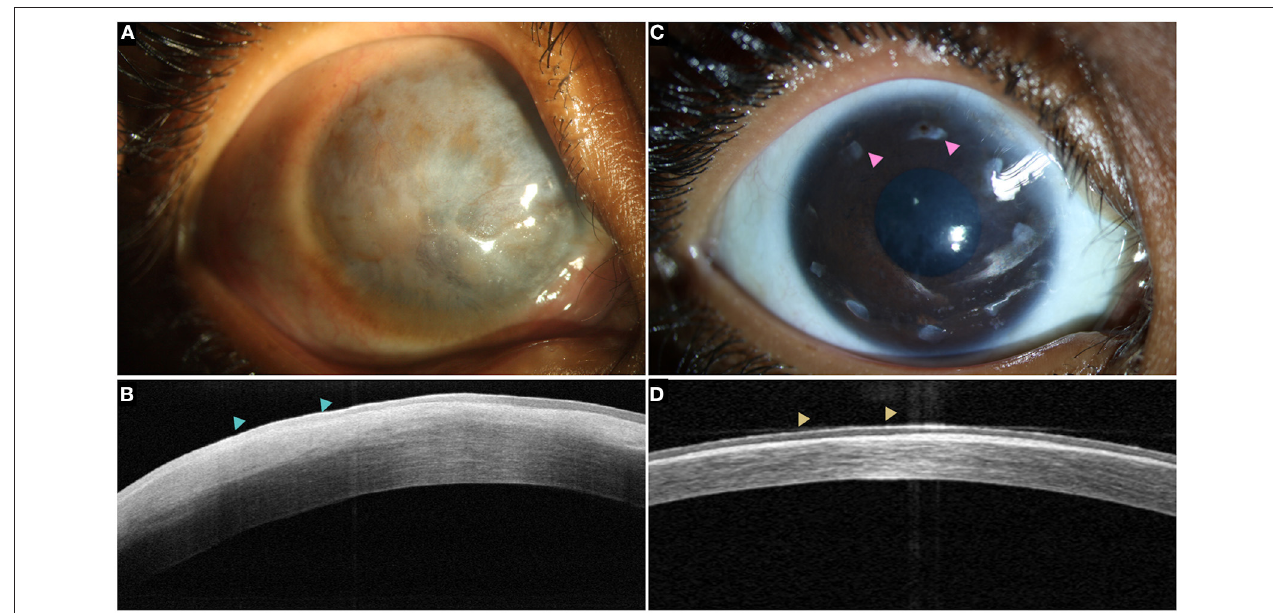
FIGURE 9 | (A) Total LSCD with a thick pannus in a case of chronic vernal keratoconjunctivitis with hyperreflective epithelium (blue arrowheads) on the optical coherence tomography (OCT) line scan (B) . (C) A stable ocular surface is observed following allogeneic simple epithelial limbal transplantation. The intact limbal tissues are also visible (pink arrowheads). (D) Restoration of epithelium with a normal reflectivity is noted on the OCT scan (yellow arrowheads).